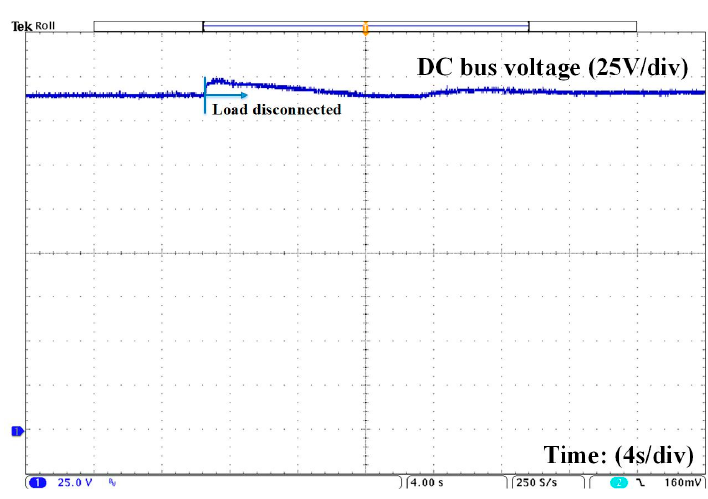
Figure 22. Disconnection of 400 W fluorescent lamps.